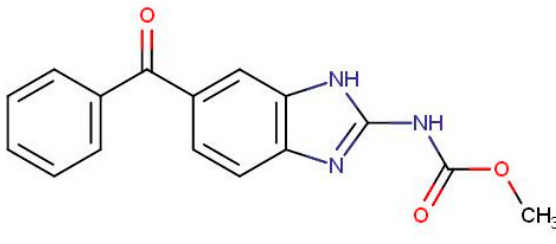
Figure 1. Structure of mebendazole.